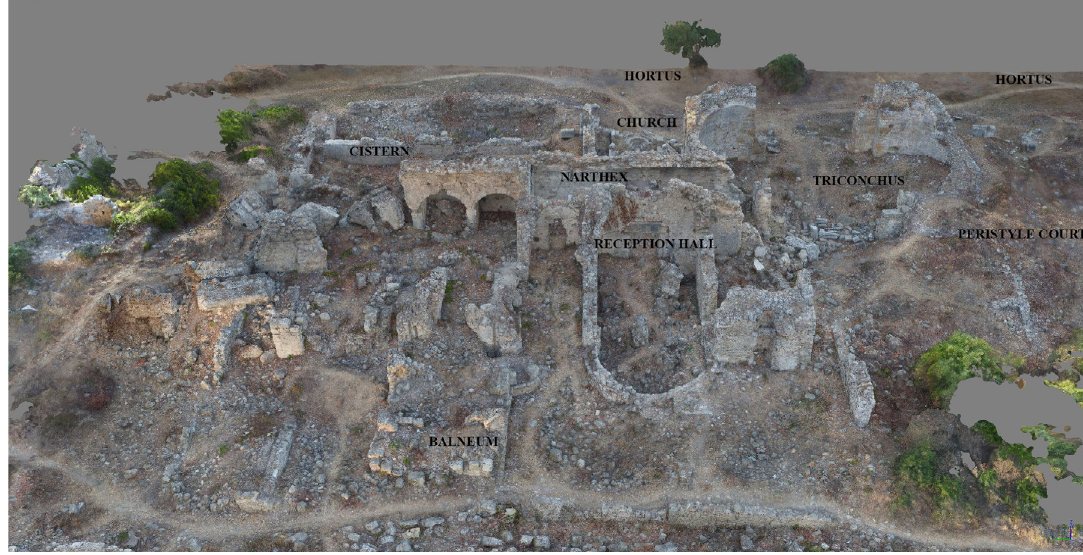
Figure 2. Episcopal residence, 3D model view to the east © ÖAW/IKAnt (M. Hernandez